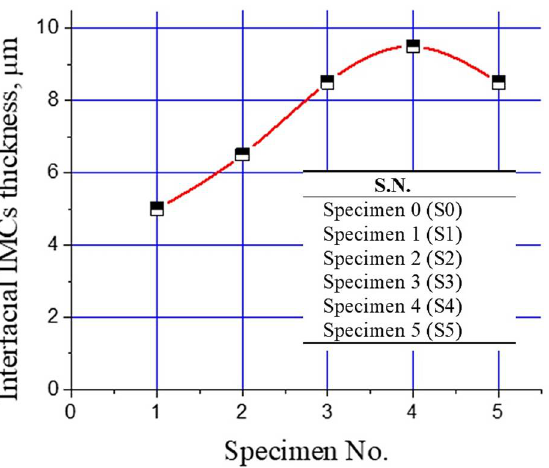
Figure 8. Plot of interfacial IMCs layer thickness for different bimetal castings prepared in this